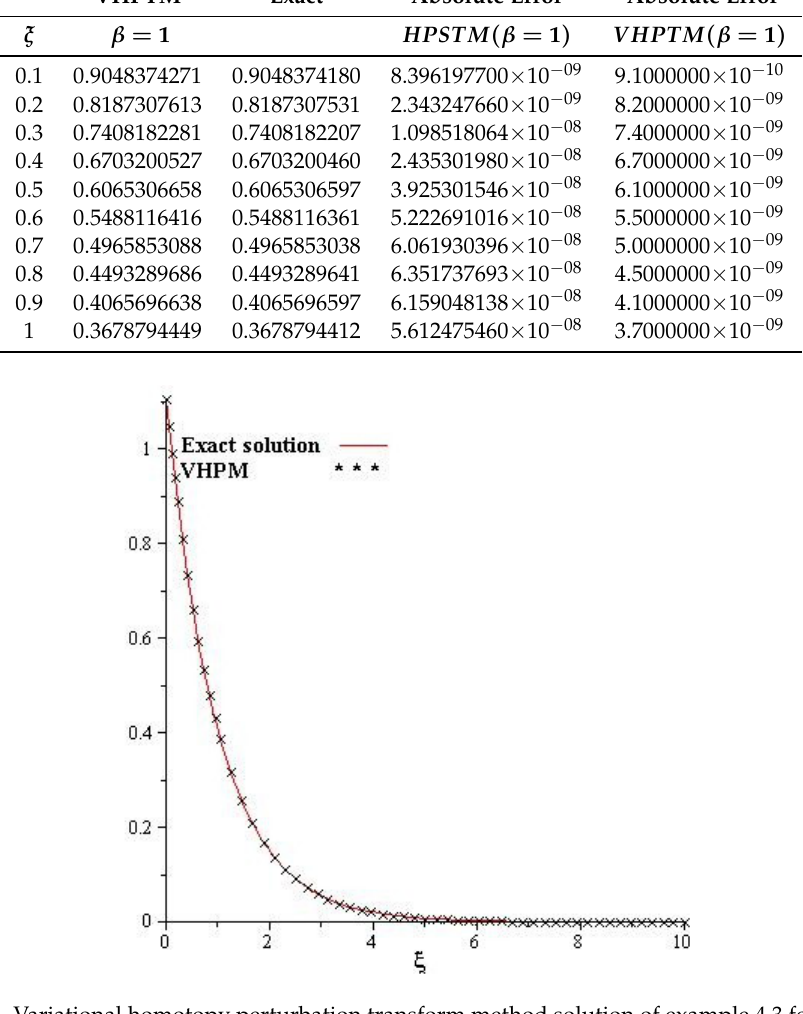
Figure 5. Variational homotopy perturbation transform method solution of example 4.3 for β =